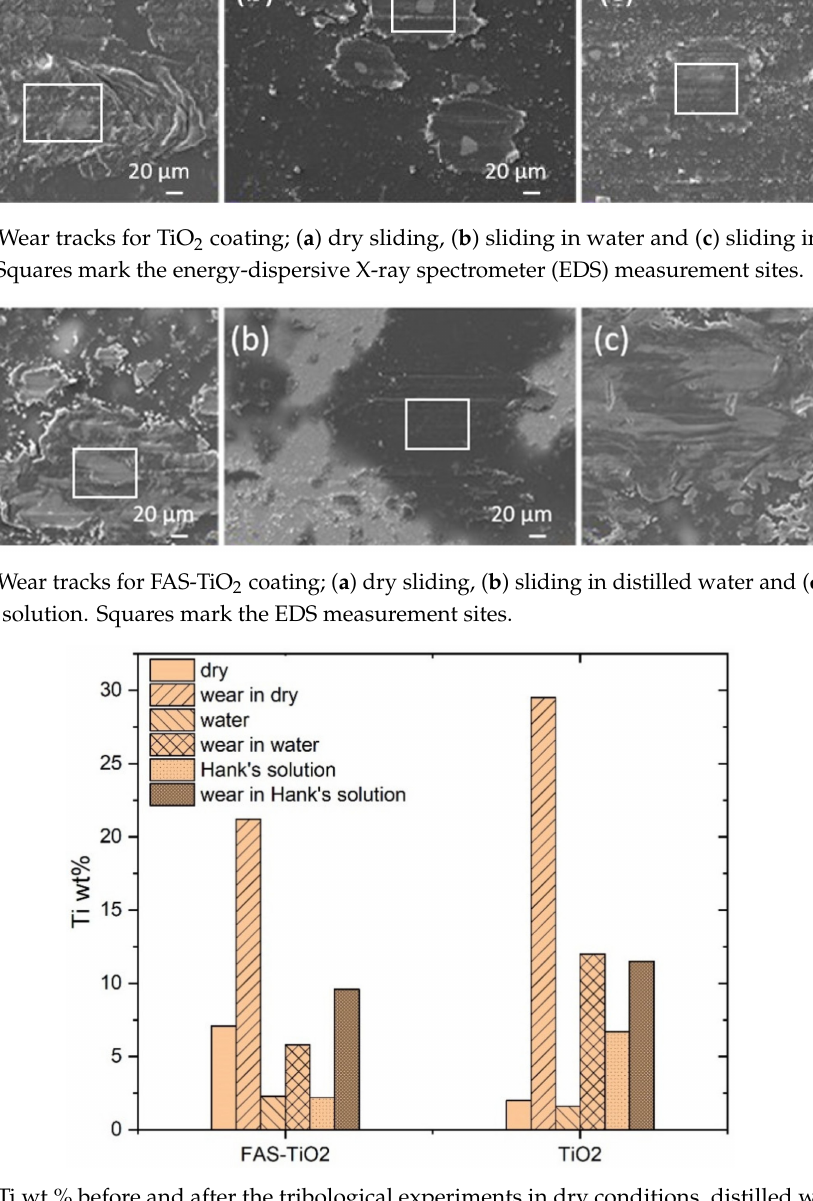
Figure 6. Ti wt.% before and after the tribological experiments in dry conditions, distilled water and Hank’s solution on epoxy / FAS-TiO 2 / epoxy and epoxy / TiO 2 / epoxy coatings, as determined by the EDS analysis. The sites of the EDS measurements for the worn surfaces are marked with squares in Figures 4 and